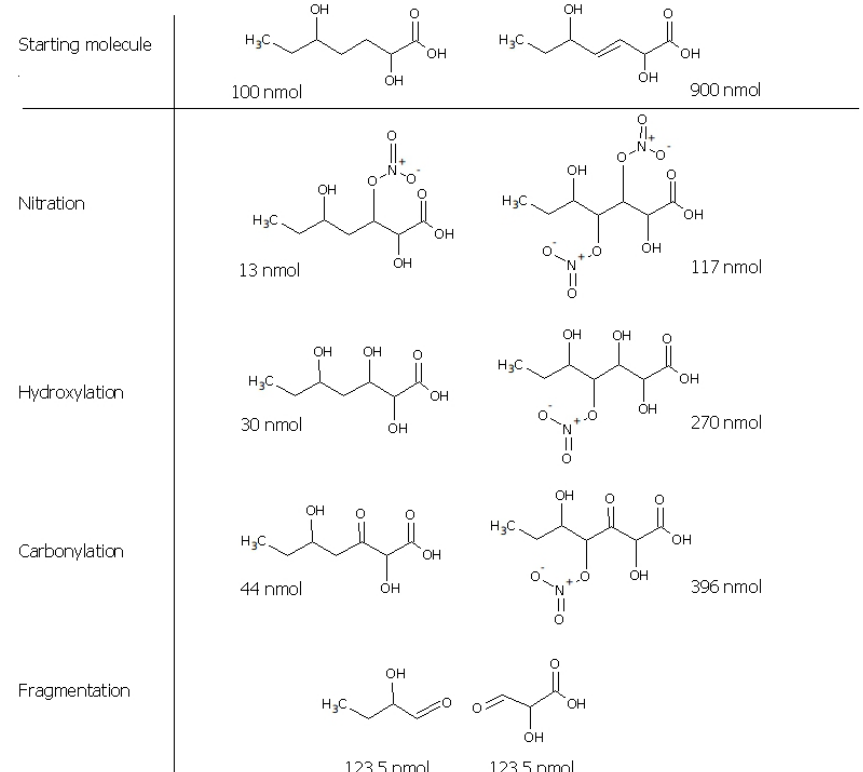
Fig. 3. Functional group composition of the products of 1µmol of 7-carbon model aerosol molecules, of which 10% are saturated and 90% unsaturated. We show quantitative yields of saturated (left) and unsaturated (right) molecules as predicted by the mechanism employed here.